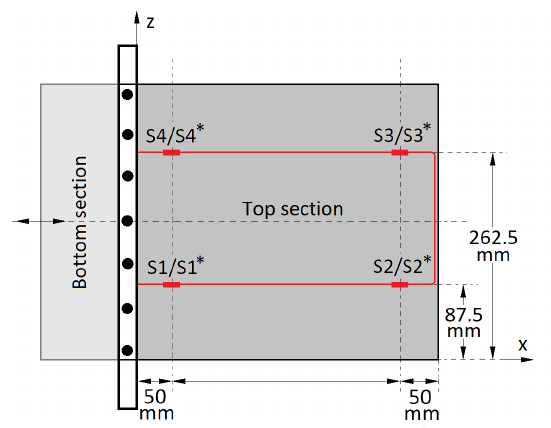
Figure 7. Top-view of the wing with the optical fibre running along the x-axis in the bulk of the top (and bottom) section(s). The grating sensors S 1, S 2, S 3 and S 4 are on the top section. The sensors on the bottom section are a superimposition of the top sensor positions marked with asterisks ( ∗ ); (e.g., S 1 directly above S 1 ∗ and so on).